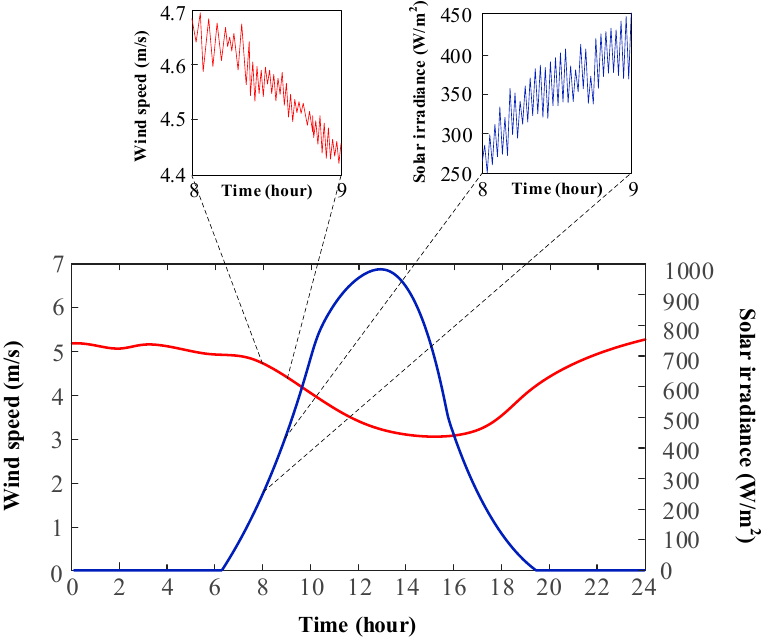
Figure 4. The average yearly wind speed and solar irradiance.